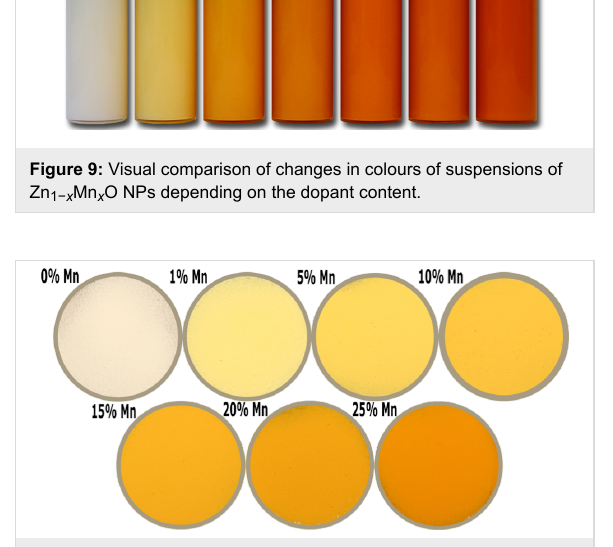
Figure 10: Visual comparison of changes in colours of dry powder of Zn 1 − x Mn x O NPs depending on the dopant